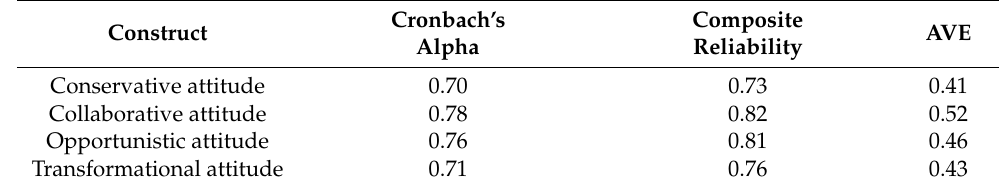
Table 4. Reliability results in the research